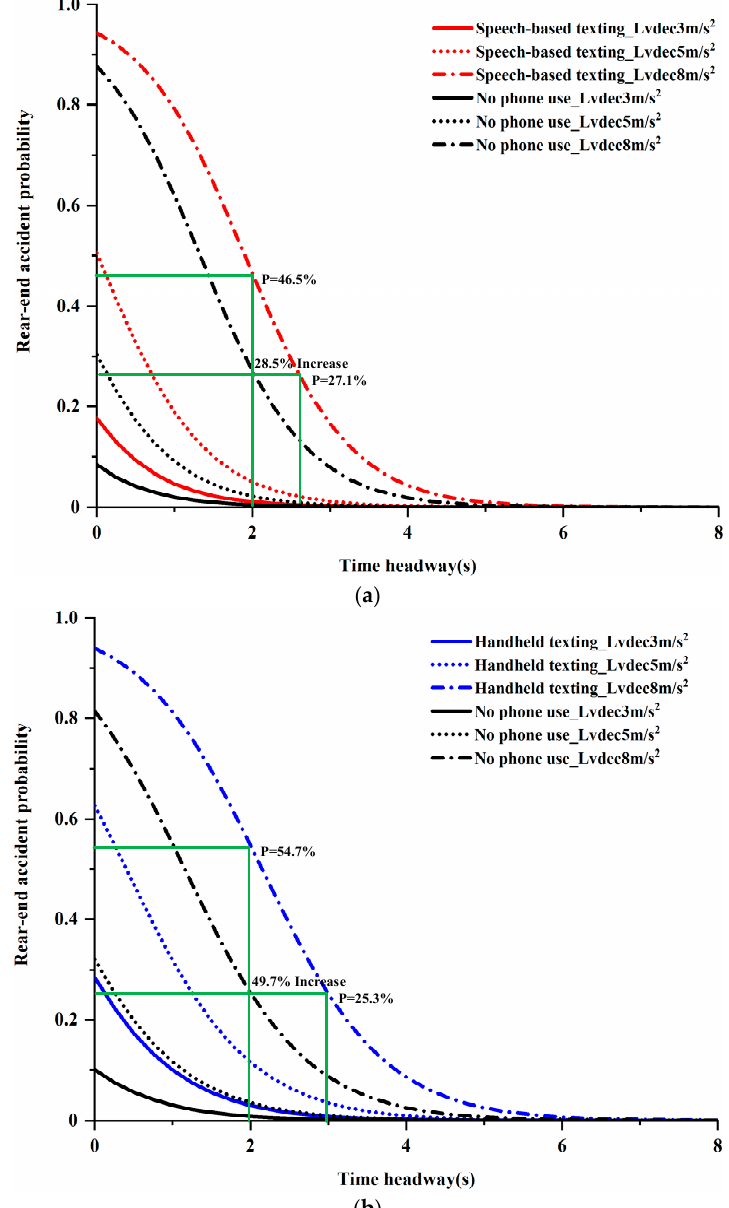
Figure 3. Comparison of rear-end accident probabilities for non-distracted and distracted